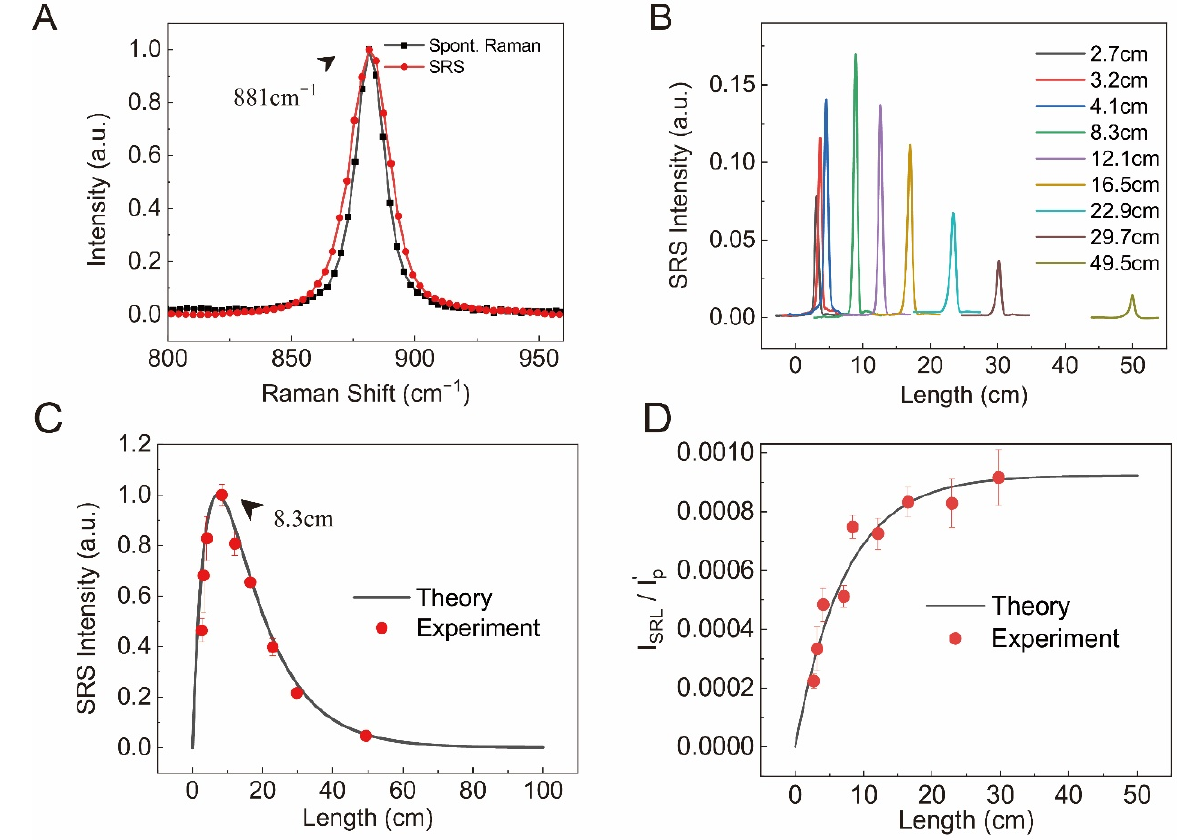
Figure 2. ( A ) Spontaneous Raman and SRS spectra of ethanol at ~881 cm − 1 ; ( B ) SRS spectra of ethanol with different fiber lengths; ( C ) the normalized experimental data versus the theoretical prediction of the relationship between the SRS peak intensity and the fiber length; ( D ) the experimental data and the theoretical prediction for the fractional change of SRS to the fiber length.